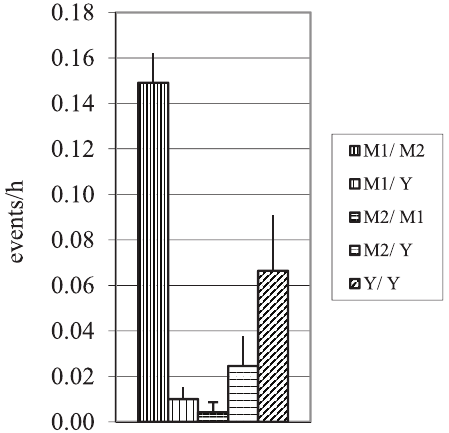
Figure 8. Replacing the sentinel by means of allofeeding (events/h±SE) among the males, among the males and the young, and among the young.